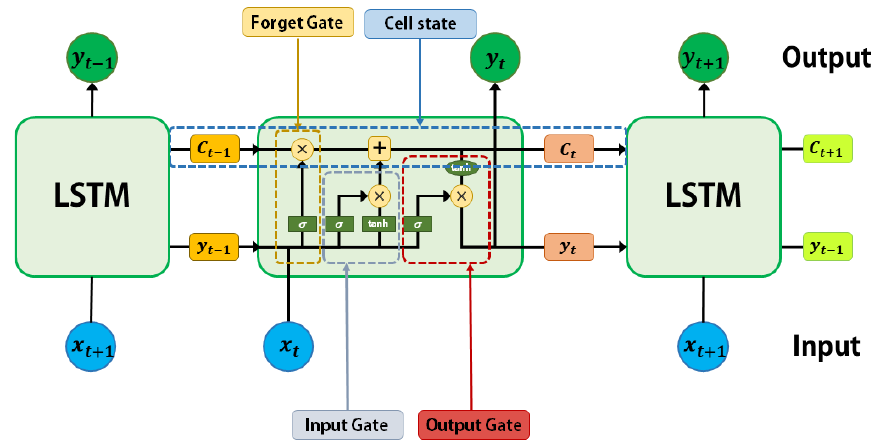
Figure 4. LSTM architecture.